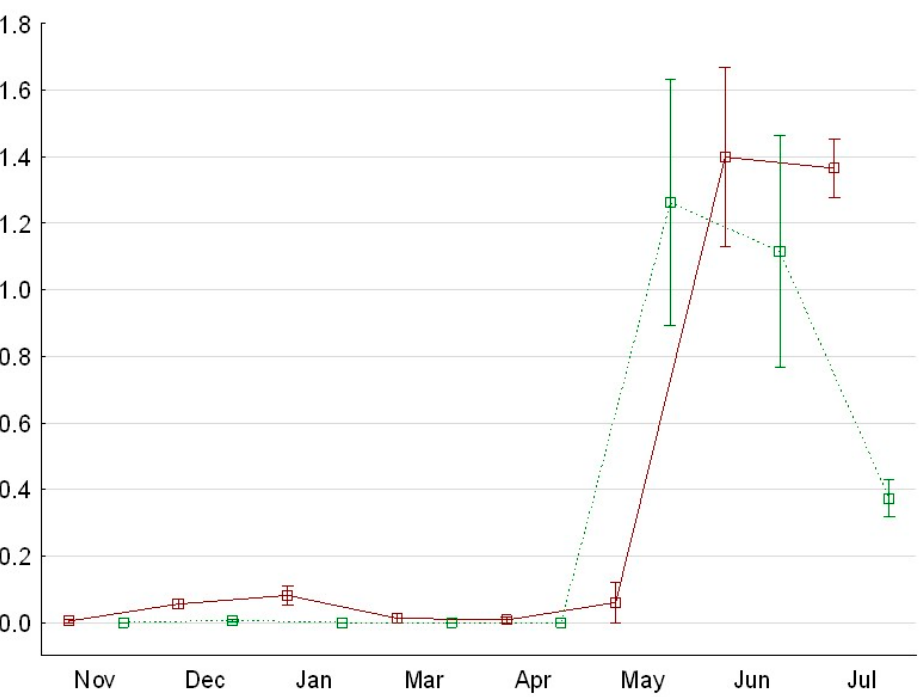
Figure 3. Number of individuals of the two main taxa using the fish lock (mugilids and European eel) per cycle (mean of log10(number+1) ± SE) in the investigated months (Continuous red line—European eel, interrupted green